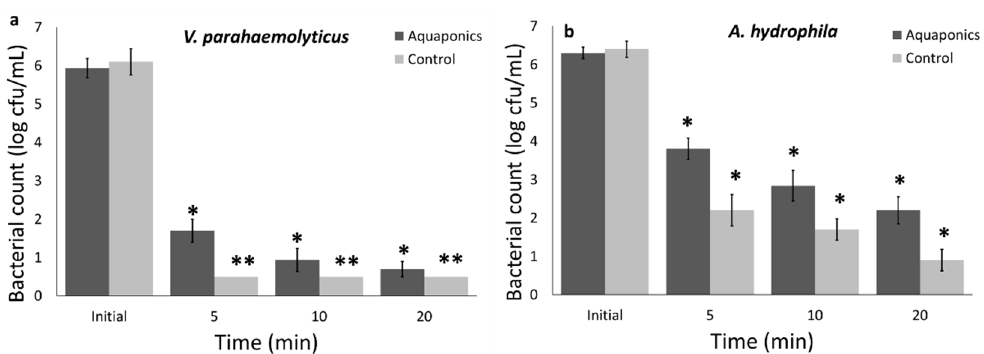
Figure 3. ( a ) V. parahaemolyticus and ( b ) A. hydrophila inactivation in PBS and aquaponics water with 6 mg/L total suspended solid (TSS), using combined UV-A and curcumin antimicrobial approach. Statistical difference was determined based on p < 0.05 (*). Samples with two asterisks (**) were below the limit of detection (0.5 log cfu/mL).